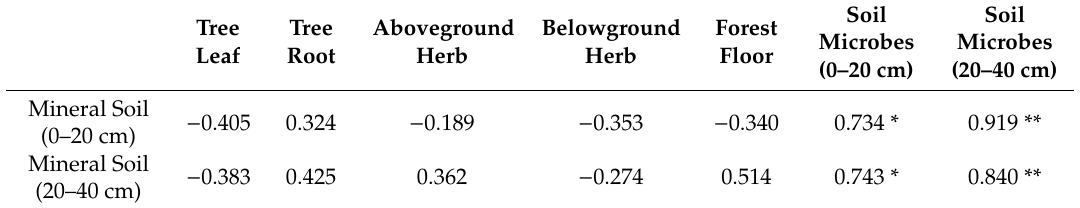
Table 2. The relationship among the di ff erent components C:N in P. asperata plantations. Tree Tree Aboveground Belowground Leaf Root Herb